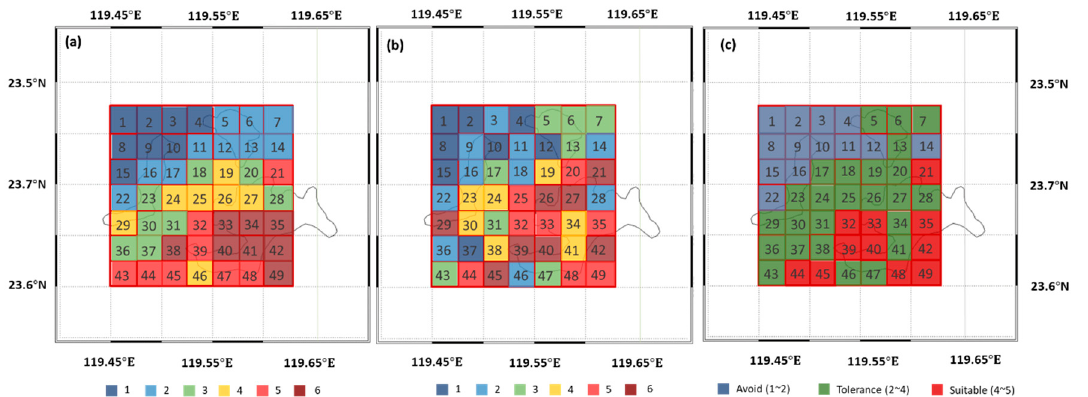
Figure 8. Spatial distributions of the two types of model selection proportion scales for ( a ) the arithmetic mean model (AMM) and ( b ) the geometric mean model (GMM). ( c ) The overlapped results of the two models selected. The avoidance sites are the blue areas. The tolerance sites are the green areas. The suitable sites are the red areas.